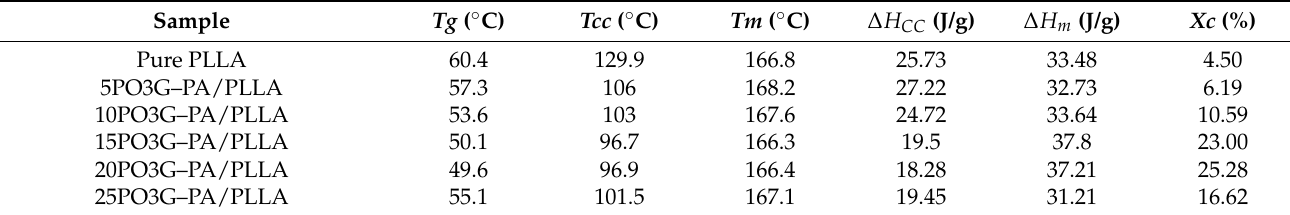
Figure 6. Primary heating and secondary heating of DSC of PO3G–PA/PLLA composite films with different ratios. Table 1. DSC data of PO3G–PA/PLLA composite films with different ratios.